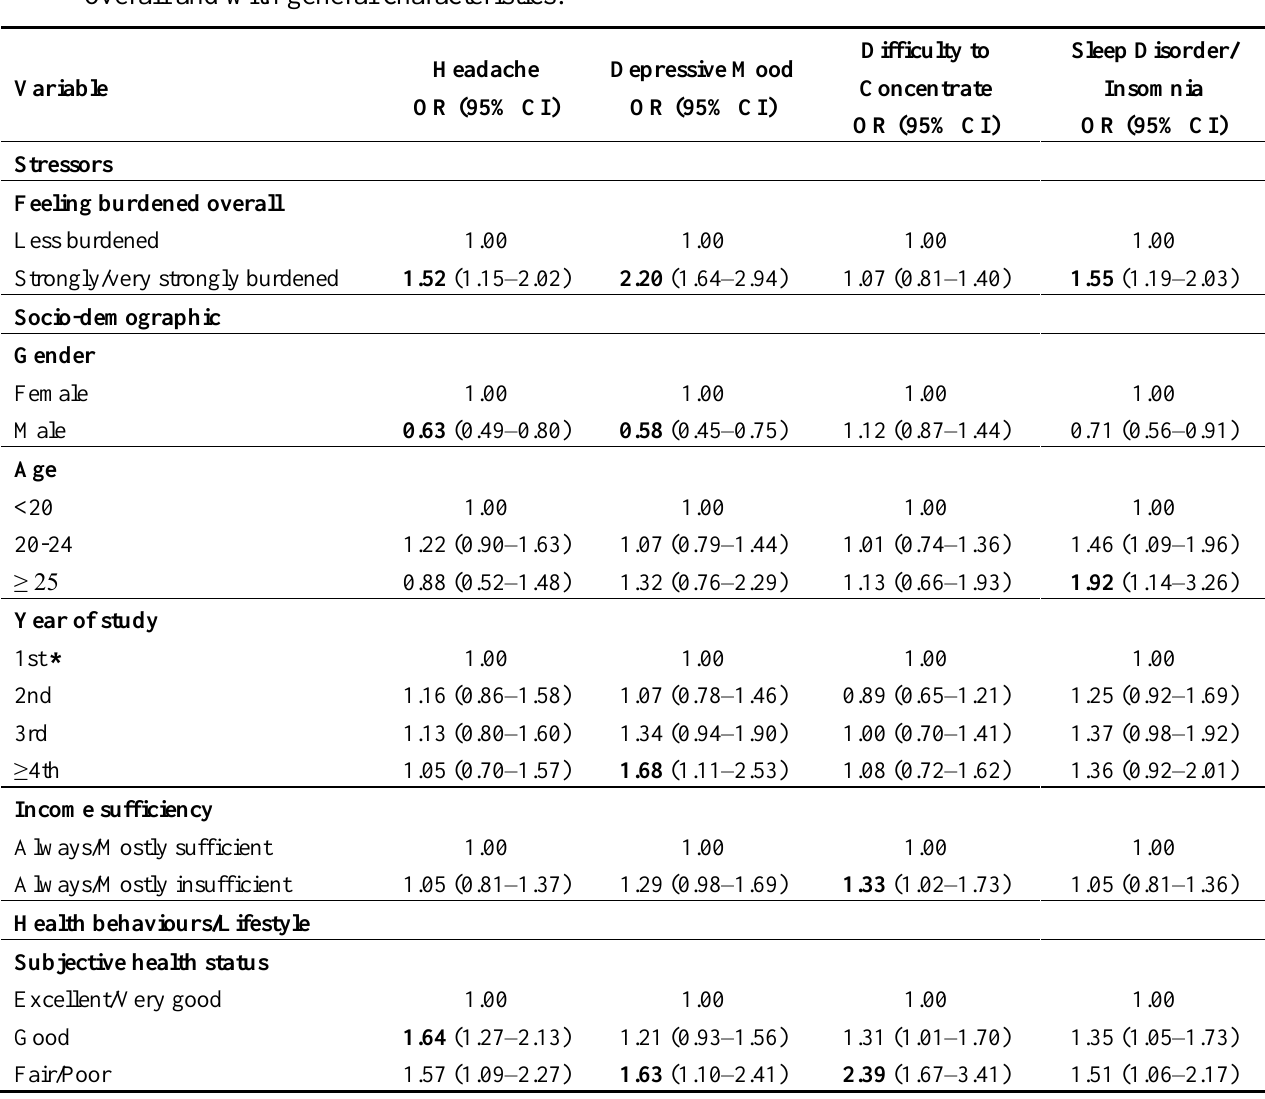
Table 6. Adjusted odds ratios for associations between symptoms and feeling burdened overall and with general